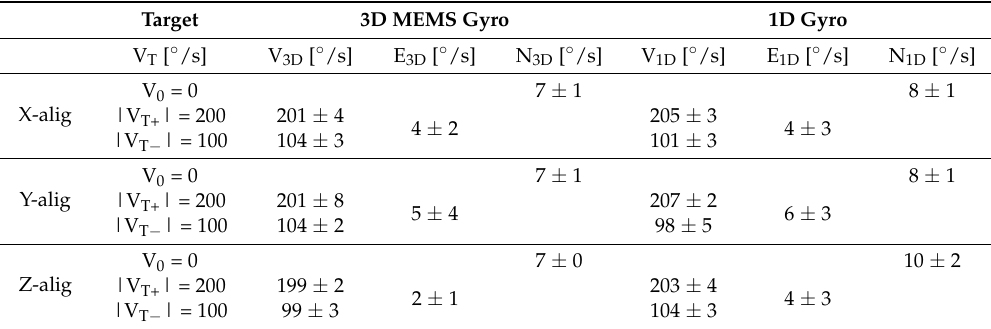
Table 2. Angular velocity signals, noises, and errors provided by the 3D gyro included in the CardioMon lead and in reference to the 1D gyro.